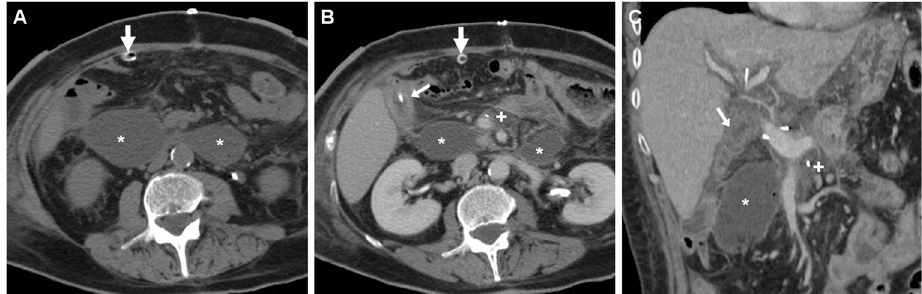
Fig. 7 Non-infected postoperative collections in a 71-year-old man following PD for duodenal adenocarcinoma, complicated by intraoperative haemorrhagic shock. During prolonged hospitalisation, unenhanced ( a ) and postcontrast ( b , c ) CT images showed B saddlebag ^ -